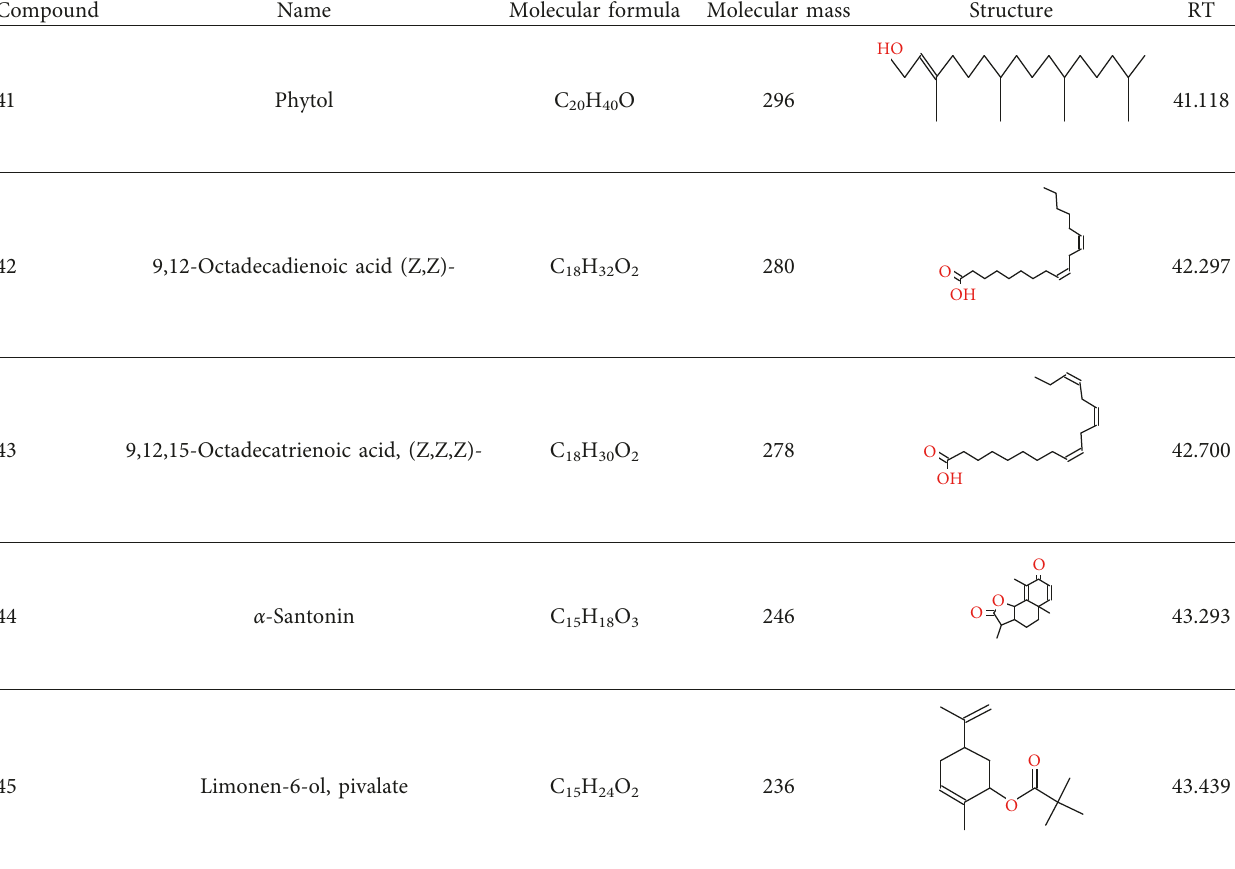
Table 10: Molecular formula, molecular mass, structure, and RT of compounds 41–45 of whole plant n -hexane fraction of Achillea wilhelmsii